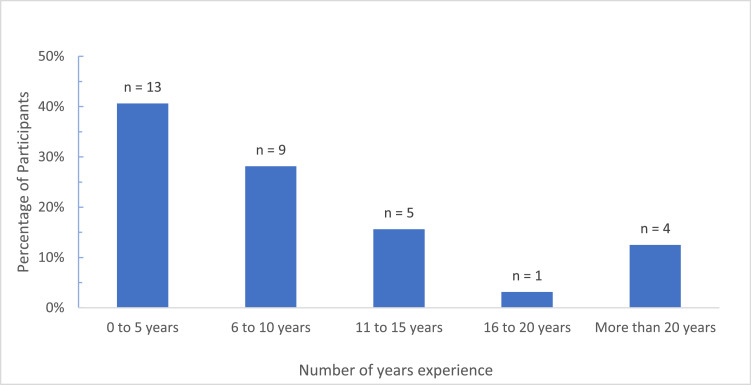
Participants by Years of Experience.